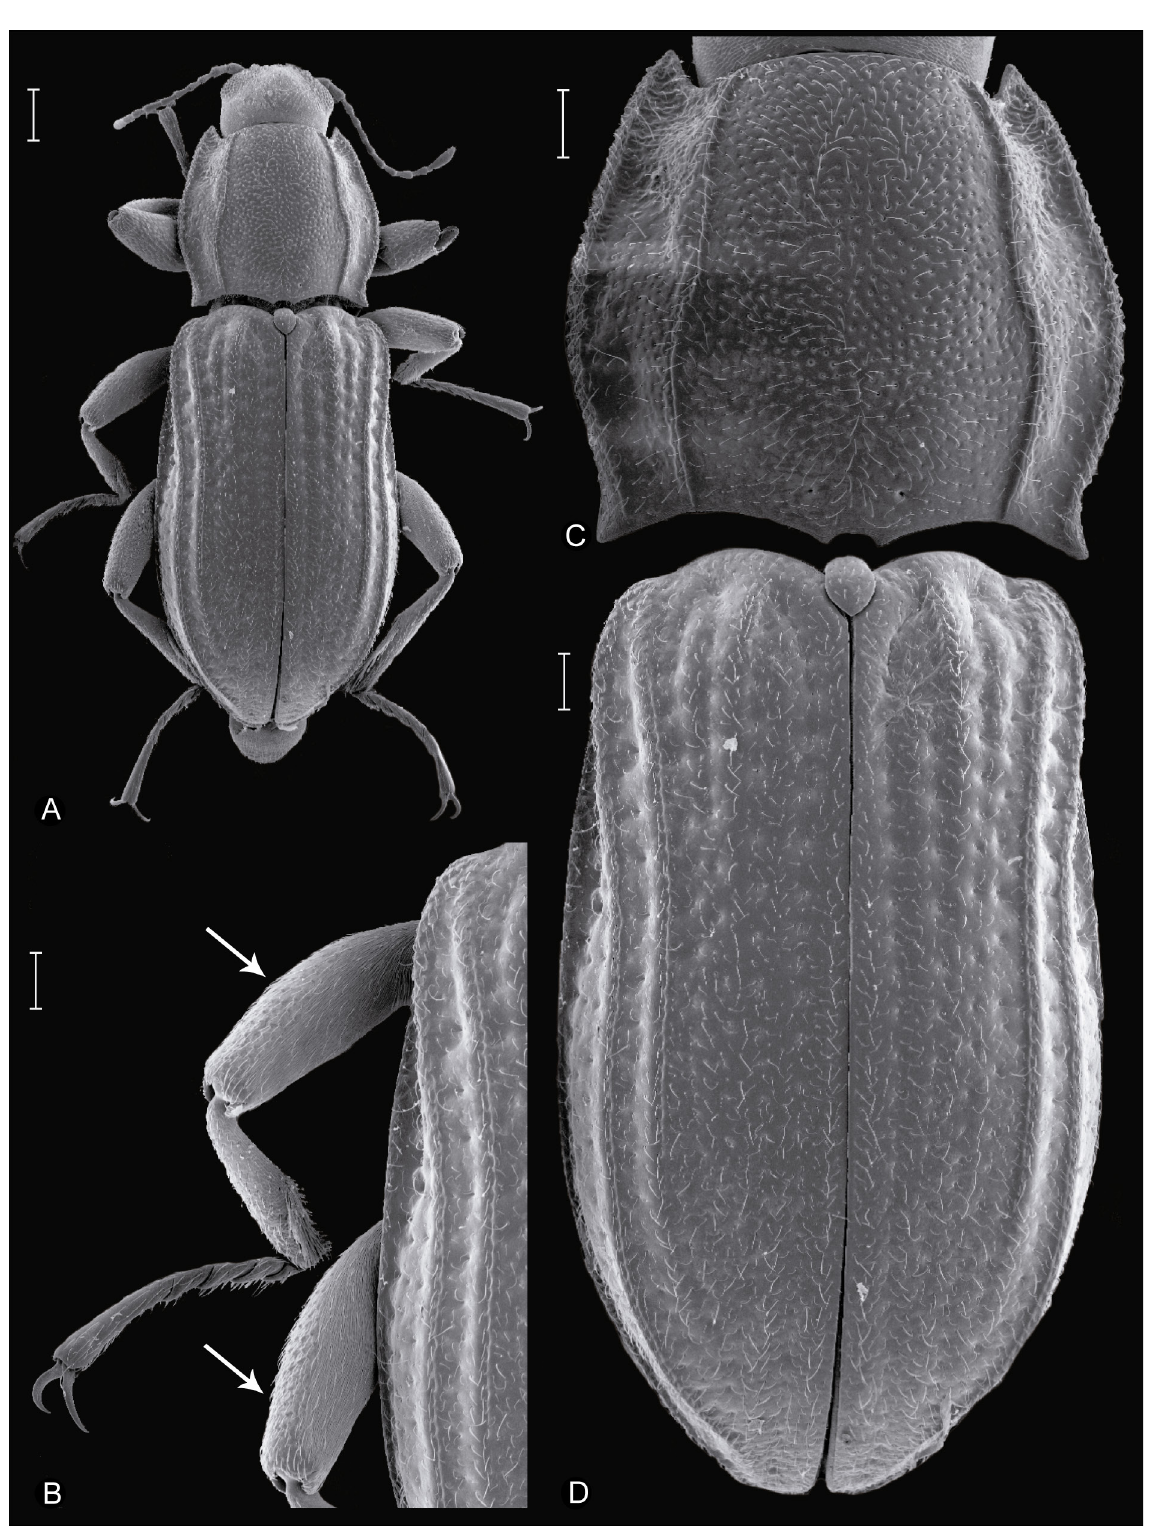
Fig. 6. Spanglerelmis xiririca Polizei & Bispo gen. et sp. nov. under scanning electron microscope, ♀ (MZSP31480). Dorsal view. A . Habitus. B . Middle leg (arrows showing the pattern of tomentum on femur). C . Pronotum. D . Elytra. Scale bars: A = 0.2 mm; B–D = 0.1